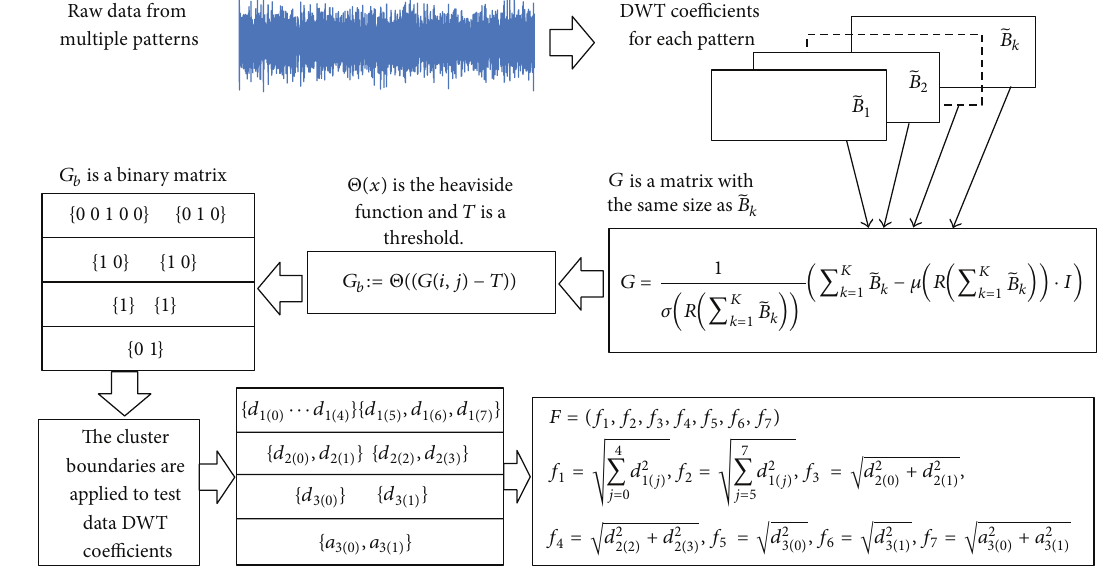
Figure 3: Feature extraction from DWT coefficients